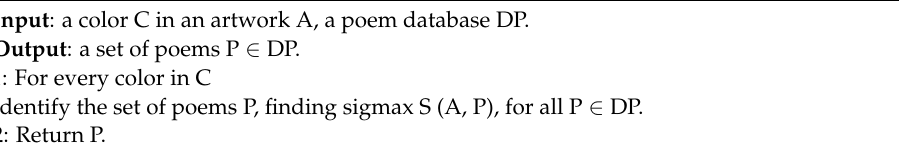
Algorithm 1 ColorPoetry (i.e., Poetry Coding Colors).